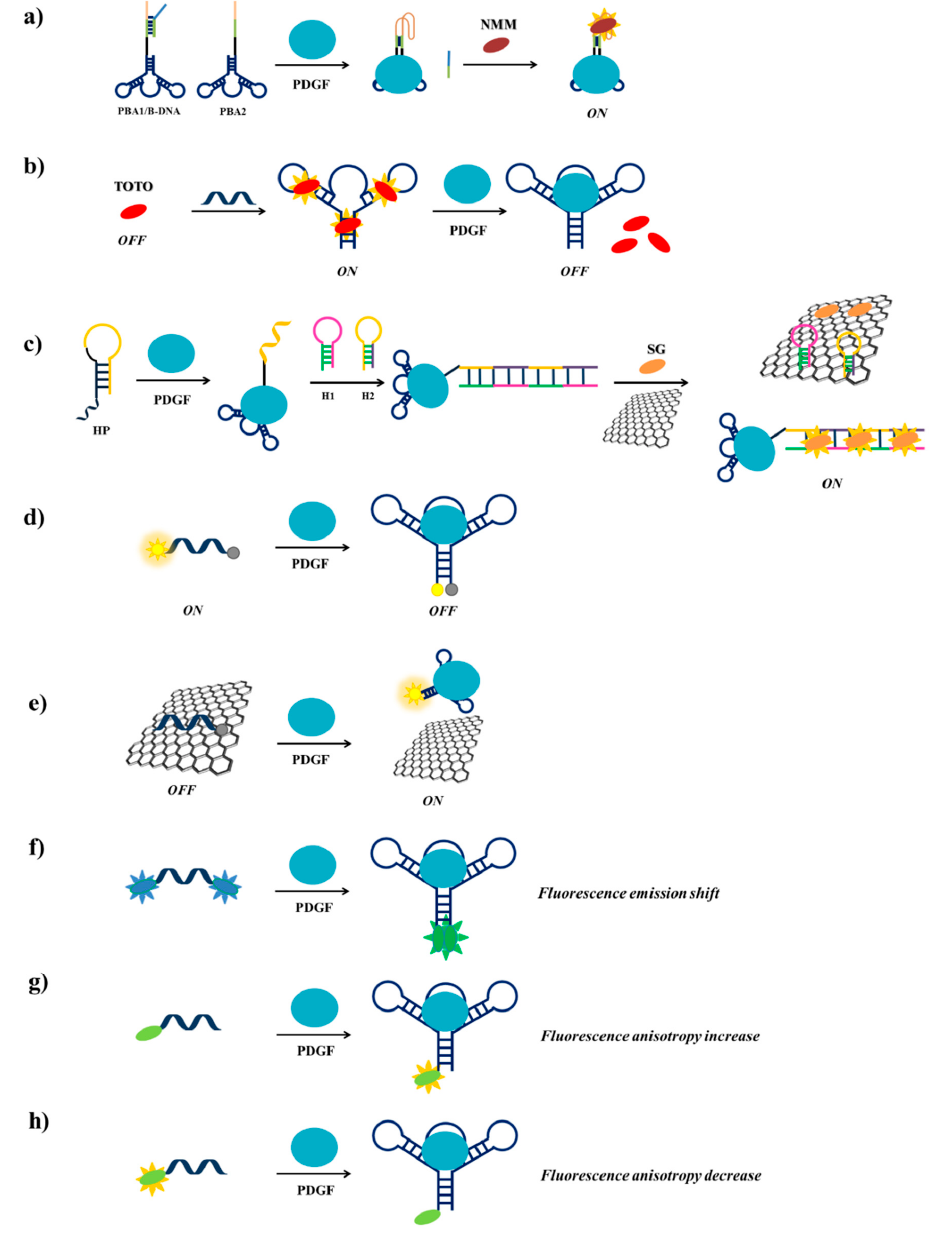
Figure 14. Schematic representation of PDGF detection strategies using label-free ( a–c ) or fluorescently-labelled ( d–h )